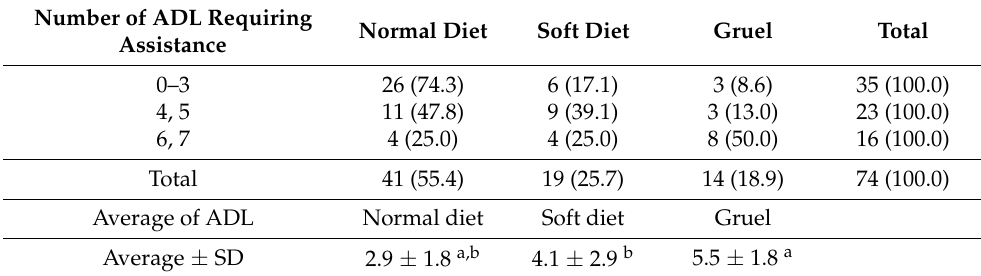
Table 4. Comparison of diet status and general